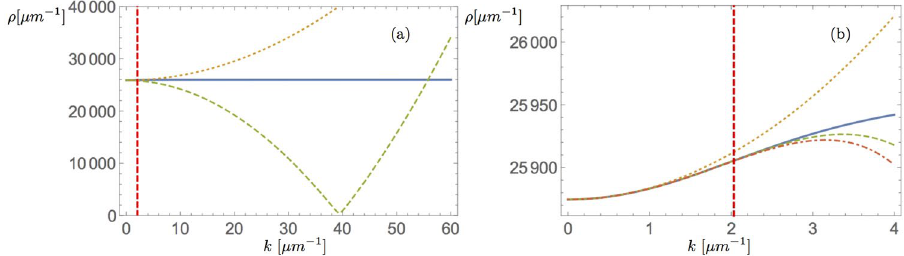
Figure 2. ( a ) The density of plane wave solutions for the lower polariton branch: Solid line corresponds to the plane wave for the lower polariton dispersion, dotted line to the parabolic approximation with energy shift and the dashed line to the plane waves according to an effective negative mass model. The vertical red-dashed line is at the inflection point. ( b ) Plane wave solutions of the lower branch: The lines are associated as follows: Continuous line corresponds to the full dispersion, the dotted line to the parabolic dispersion with offset, the dashed line to the Taylor approximation of the dispersion at k = 0 to order four and the dotted-dashed line to the order